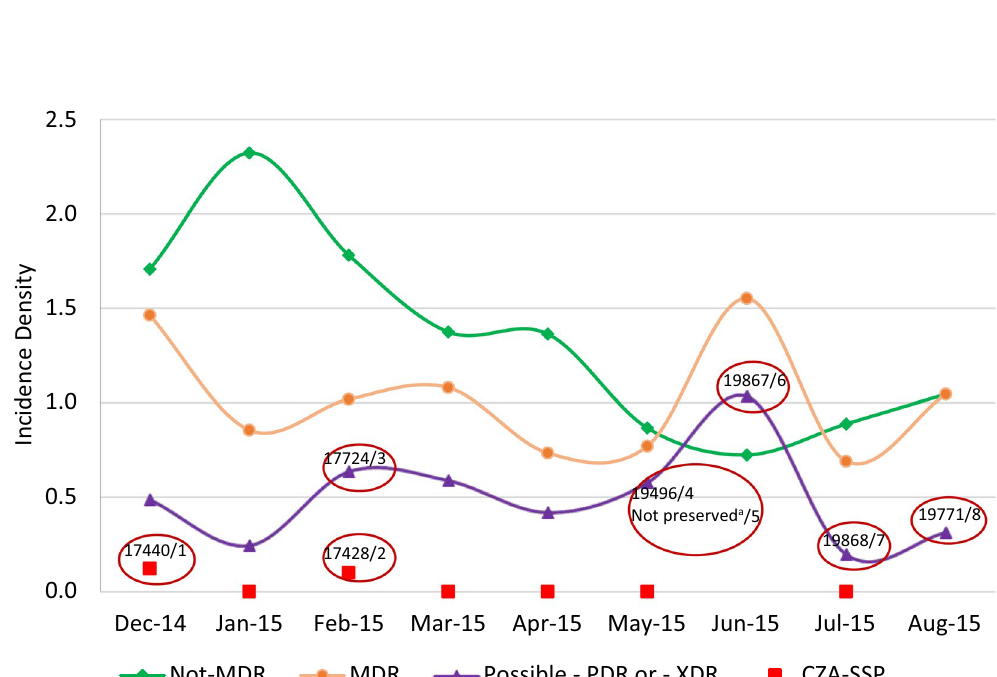
Figure 2. Incidence density of K. pneumoniae complex phenotypes detected in clinical samples/1000 patient- days, hospital-wide surveillance (n = 196 isolates; median of 22 isolates per month, range 17–26). The temporal occurrences of cases with polymyxin/carbapenem-resistant K. pneumoniae strains are represented with red circles (CCBH #/case #) over their corresponding phenotype curves. Case number in order of strain detection. Superscript a: not preserved K. pneumoniae complex isolate of case 5, that displayed carbapenem resistance and had positive screening for polymyxin resistance . CZA-SSP ceftazidime-avibactam single susceptible profile, MDR multidrug resistant, XDR extensively drug resistant, PDR pandrug